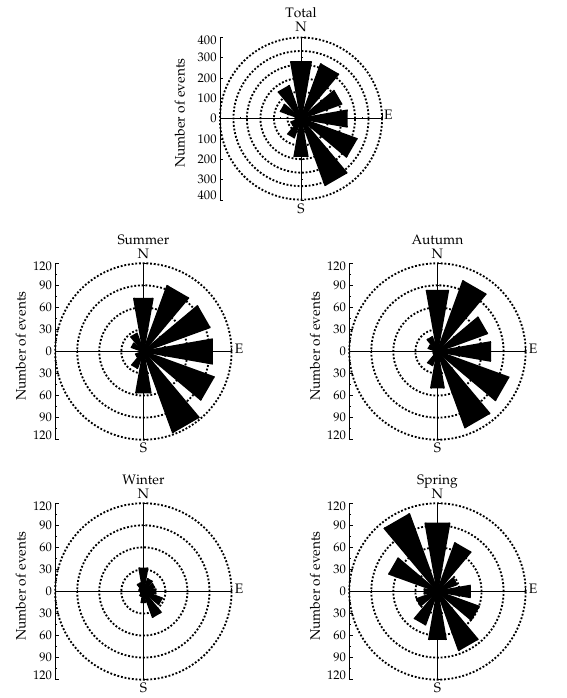
Figure 6. The number of MSGW events versus the direction of propagation for all 11 years of AGW observations (each bin has 30 ◦